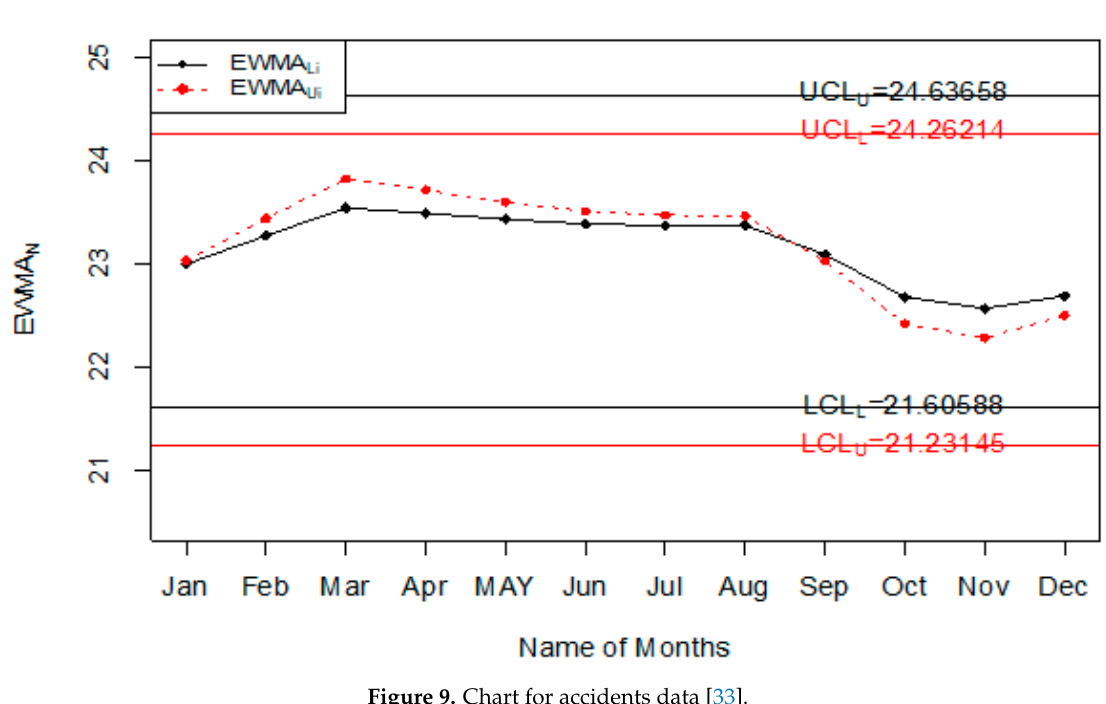
Figure 9. Chart for accidents data [33].